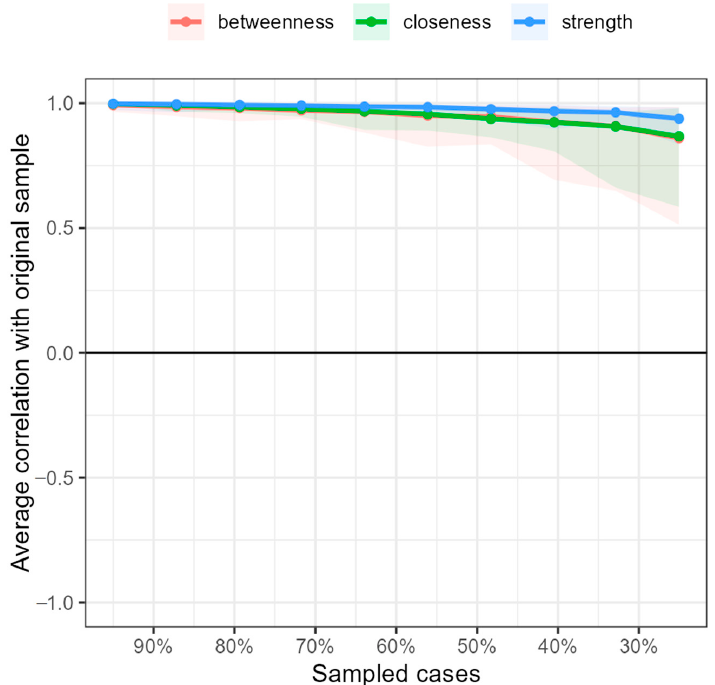
Figure 3. Stability of the ‘month’ moment network centrality indices with case dropping bootstrap subset. The x -axis indicates the percentage of cases from the original sample used in each phase. The y -axis shows the average correlations between the original network indices and those of the networks that were subsequently re-estimated by decreasing the increasing percentages of cases. The areas indicate a 95% CI and each line represents the correlations of betweenness, strength, and closeness.